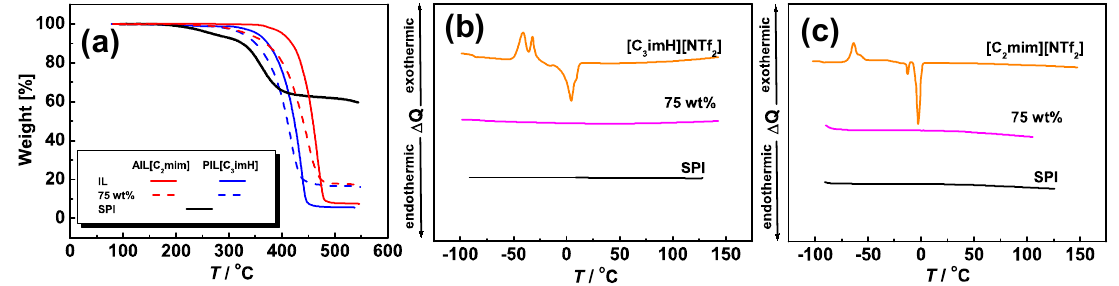
Figure 2. Thermogravimetric curves for ion gels containing 75 wt% of PIL[C 3 imH][NTf 2 ] and AIL[C 2 mim][NTf 2 ], together with neat SPI, PIL, and AIL. DSC thermograms of IL, ion gel, and SPI for ( b ) PIL[C 3 imH][NTf 2 ] and ( c ) AIL[C 2 mim][NTf 2 ].